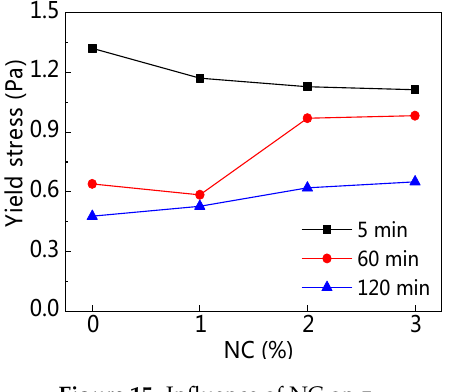
Figure 15. Influence of NC on τ 0 .